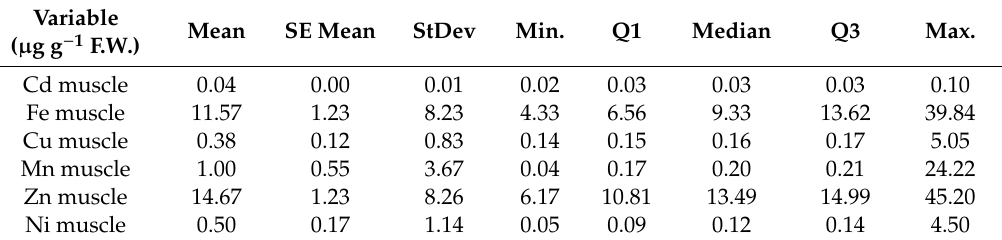
Table A4. Descriptive statistics of second group dataset.